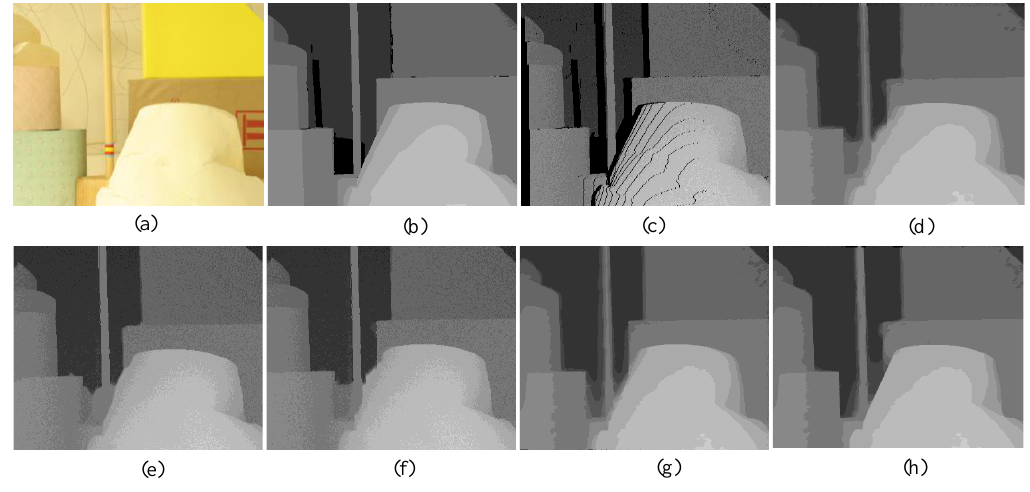
Figure 15. Results for Lampshade from the Middlebury database: ( a ) Color image; ( b ) Original depth map (right view); ( c ) Noisy image; ( d ) JBF; ( e ) FMI; ( f ) GFMI; ( g ) GFMIGF; ( h ) Proposed method.